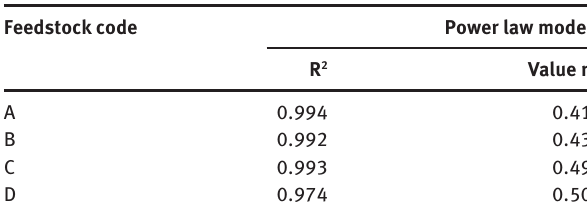
Table 3 Results of analyses of feedstocks with power law (the shear sensitivity values (n) as well as regression coefficients R 2